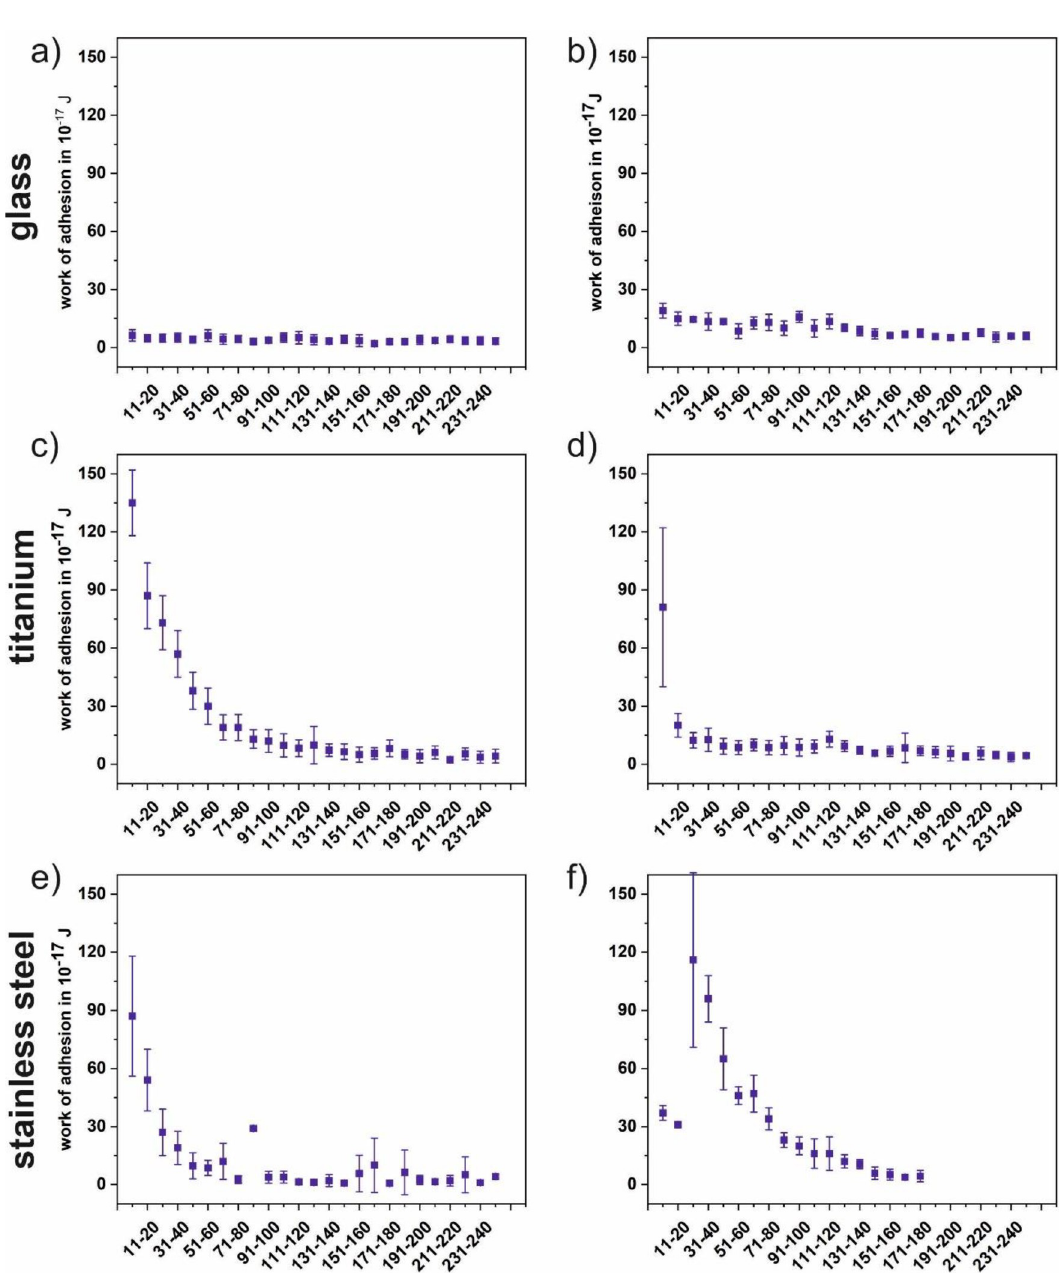
Fig 10. Work of adhesion of Paracoccus seriniphilus on glass. (a and b), titanium (c and d) and stainless steel (e and f) corresponding to the adhesion force measurements in Fig 9. The cell is immobilized on the cantilever either by polydopamine (left) or using the FluidFM approach (right). Measurement parameters were: Setpoint 2 nN, z-length 2 μ m, z-speed 2 μ m/s, pause time 5 s. For titanium only bacterium 2 from Fig 9 is shown